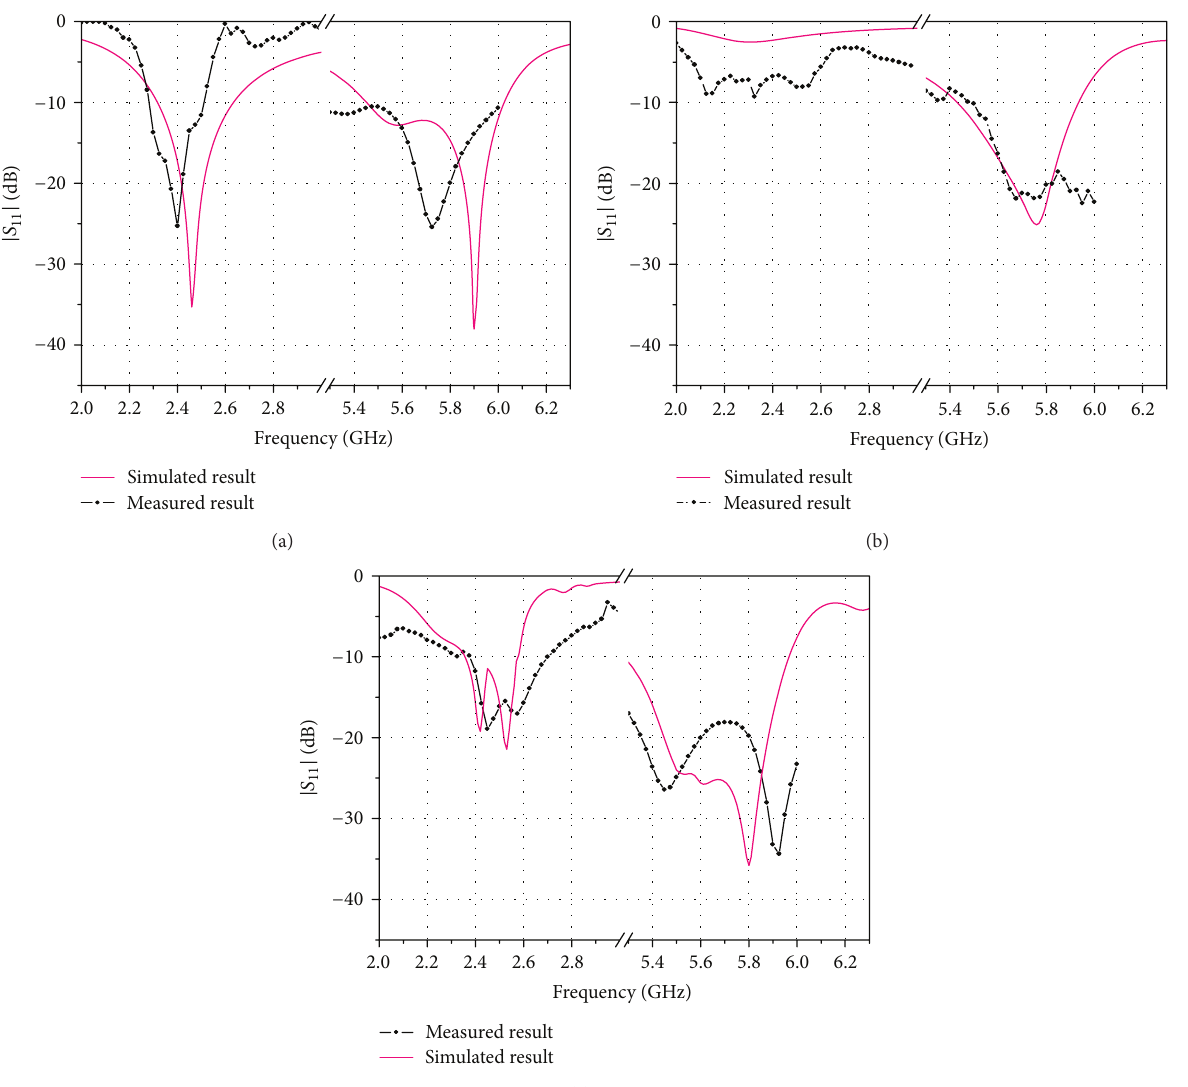
should be reduced as much as possible. Figure 11 shows the surface current distribution on the AMC patch for different reflector dimensions. As can be seen, the current distribution at the edge of the bigger reflector is much less than that of